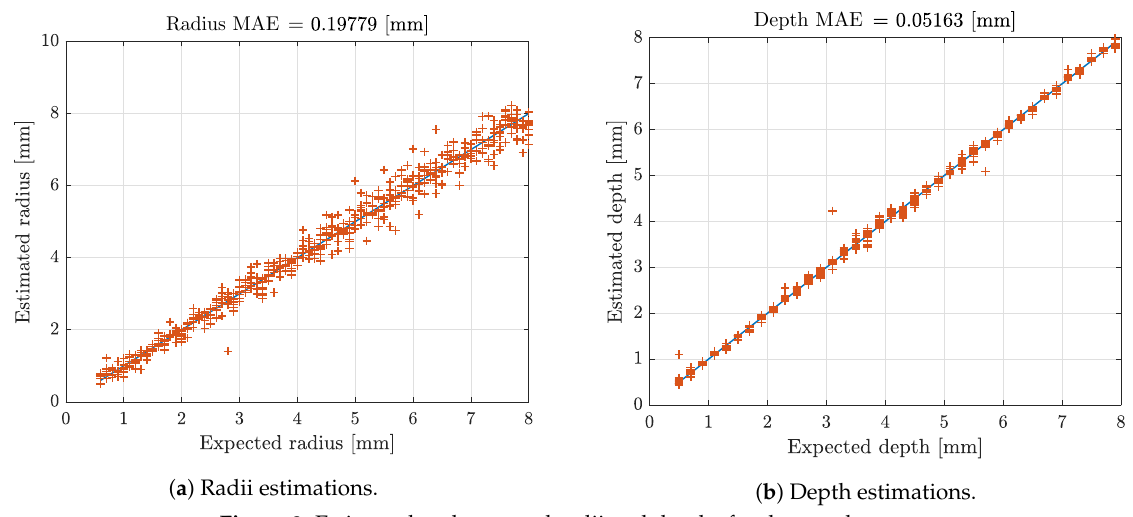
Figure 8. Estimated and expected radii and depths for the test data set.